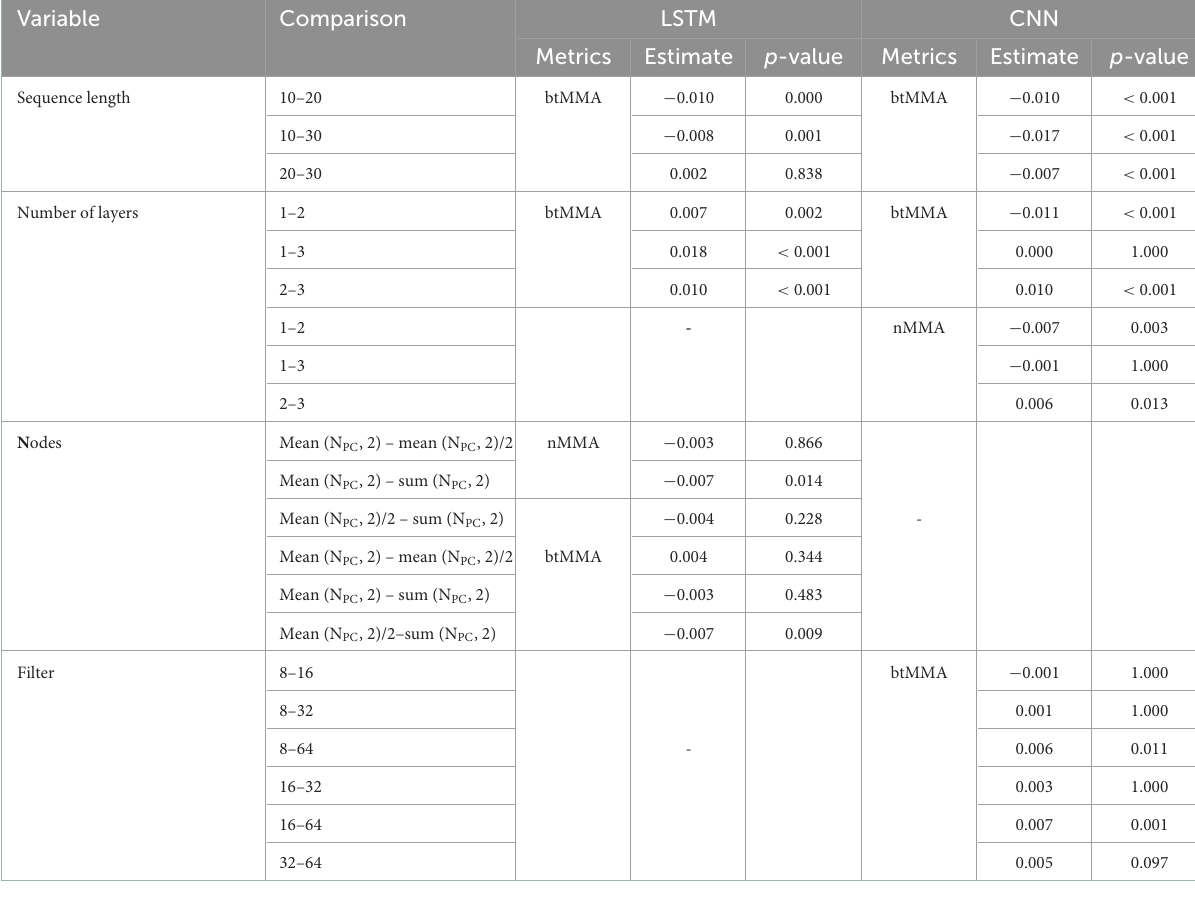
Sequence length